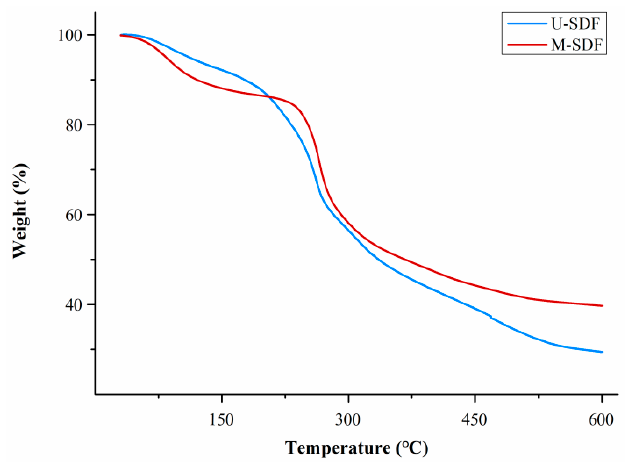
Figure 5. Thermal properties of the U-SDF and M-SDF.